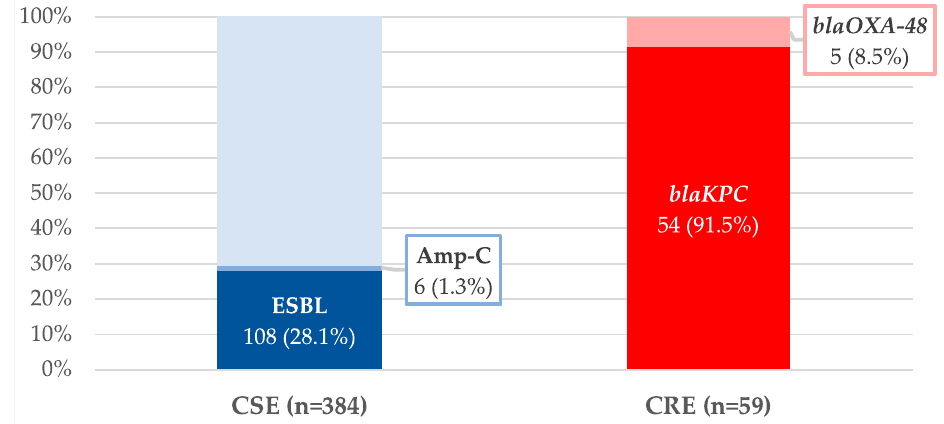
Figure 2. Resistance mechanisms of Enterobacterales. Proportion of extended-spectrum β -lactamases (ESBL) and Amp-C producers in carbapenem-susceptible Enterobacterales (CSE) isolates. Proportion of bla KPC and bla OXA-48 in carbapenem-resistant Enterobacterales (CRE) isolates.